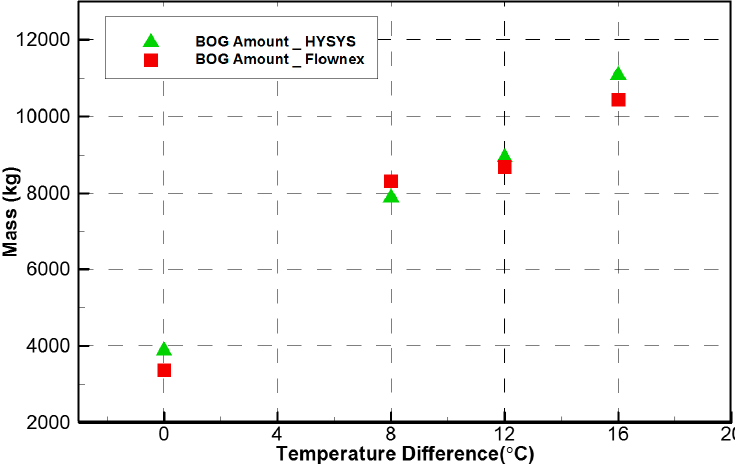
Figure 3. Comparison of HYSYS and Flownex simulation predicted the amount of BOG generation.